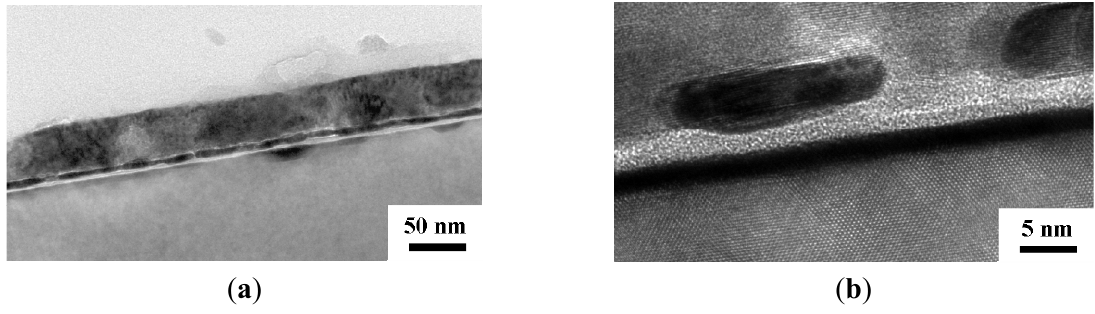
Figure 6. TEM cross section views for the structures of Cu (50 nm)/Ru (2 nm)/MgO (3 nm)/Ta (2 nm)/Si annealed for 5 min at 750 °C at a relatively low magnification ( a ); and at a relatively high magnification ( b